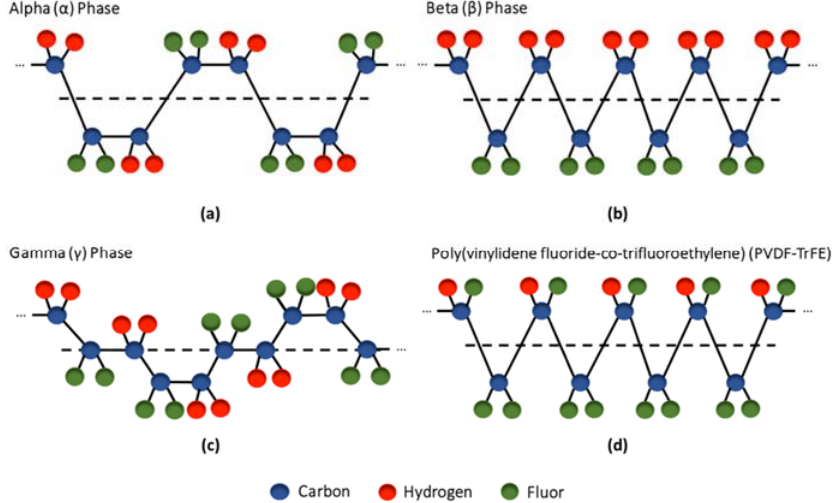
Figure 4. Chemical structures of the most common crystalline phases of PVDF: (( a )— α phase, ( b )— β phase, ( c )— γ phase) and ( d ) PVDF-TrFE piezoelectric polymers.